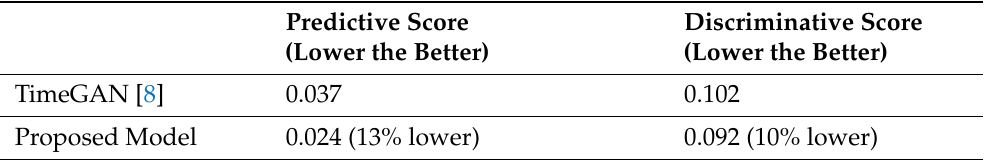
Table 5. Predictive and discriminative scores for Google stocks compared to